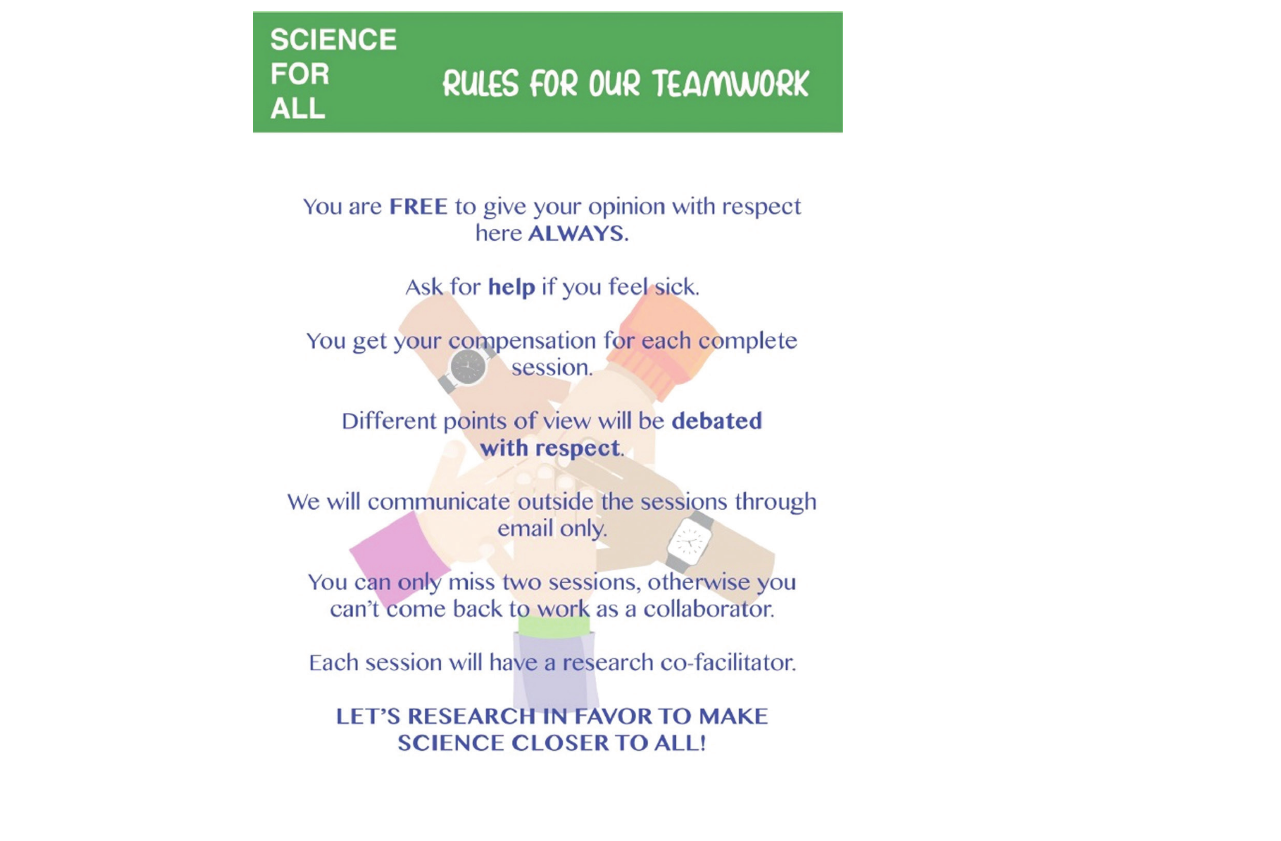
Figure 1. Rules for teamwork for Eat Smart to Play Hard (Source: Authors,